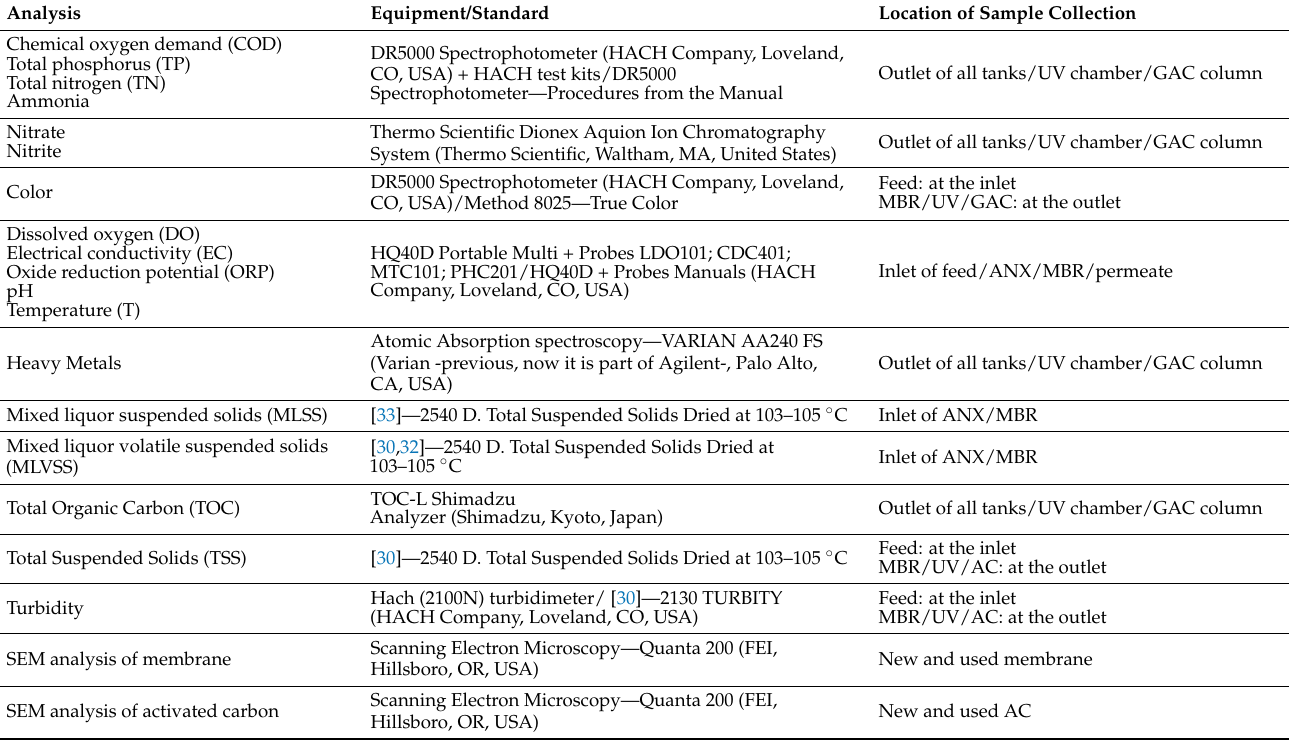
Table 2. Description of analytical methods applied during the